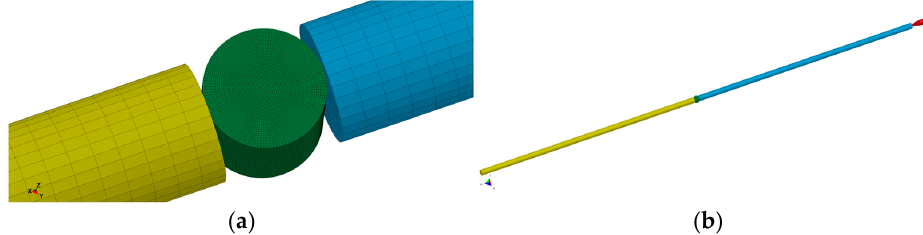
Figure 13. Numerical model of dynamic splitting test: ( a ) meshing; ( b ) three-dimensional model.